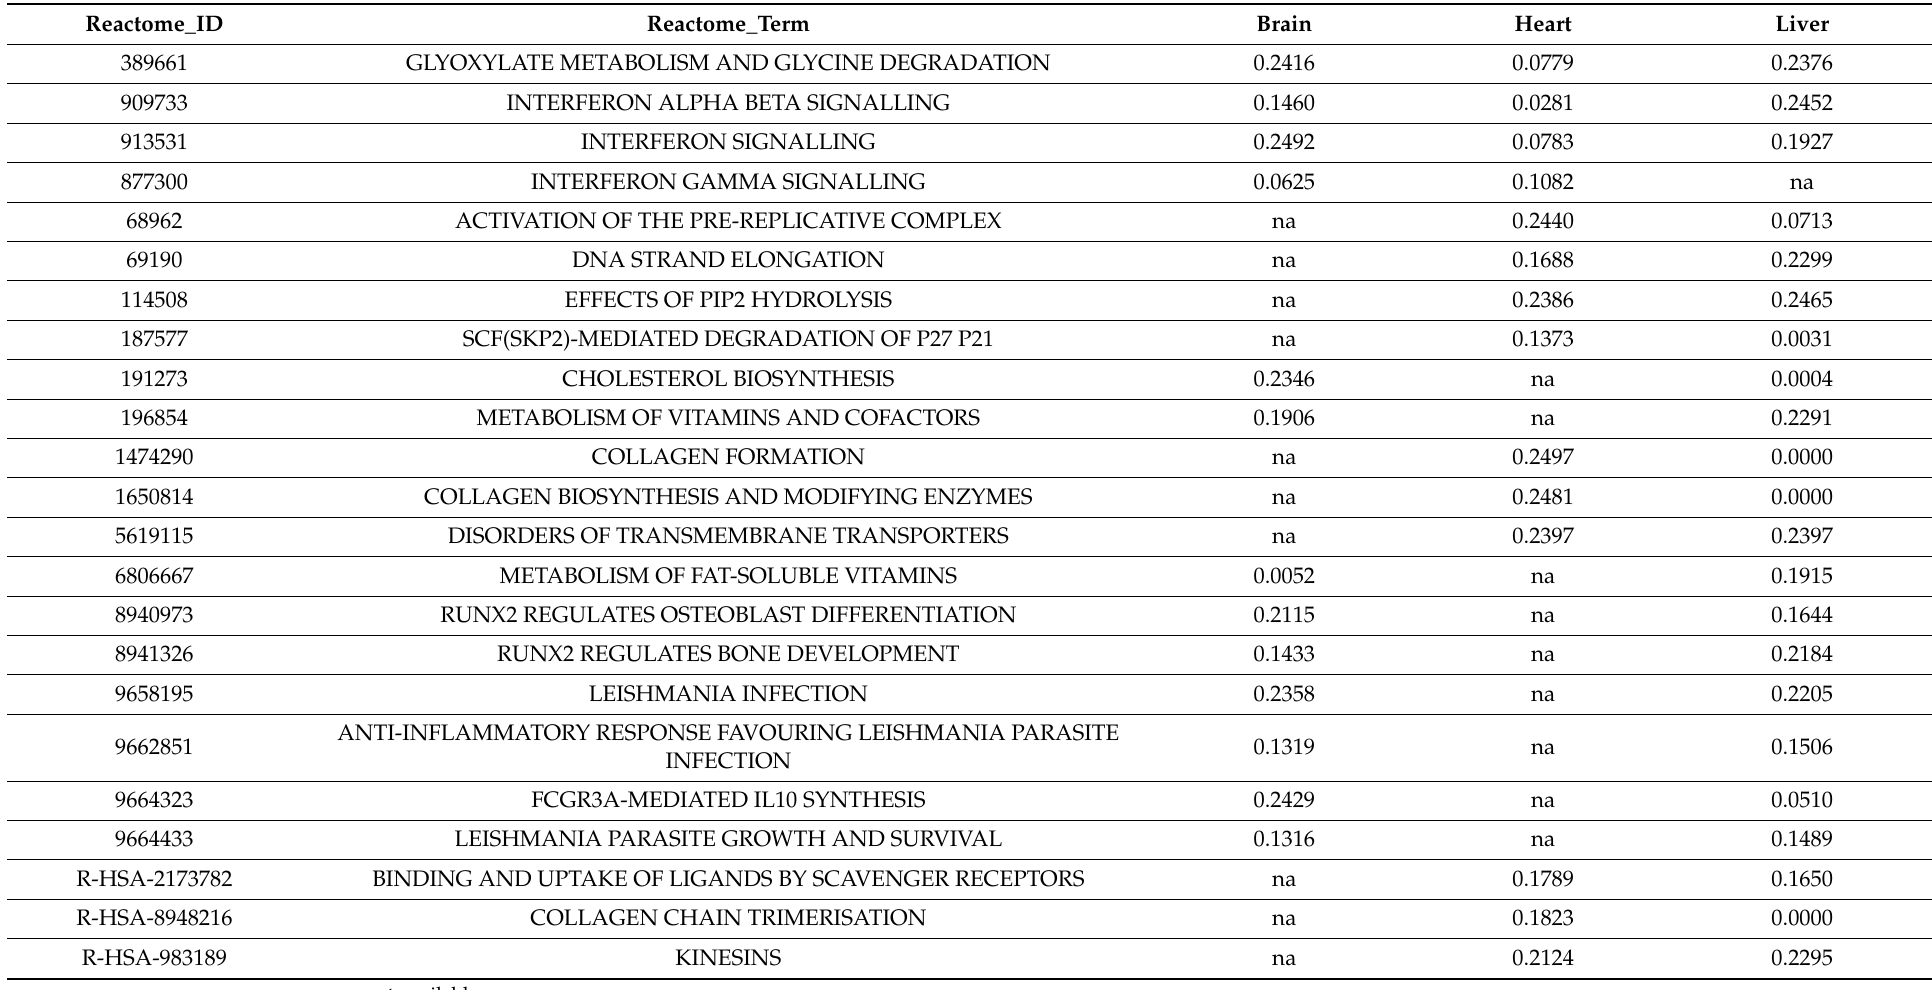
Table 2. Reactome terms commonly enriched in the comparison between control and mtDNA-supplemented pig tissue transcriptome data for more than two tissues. False discovery rate (FDR) p -values for enrichment analysis are